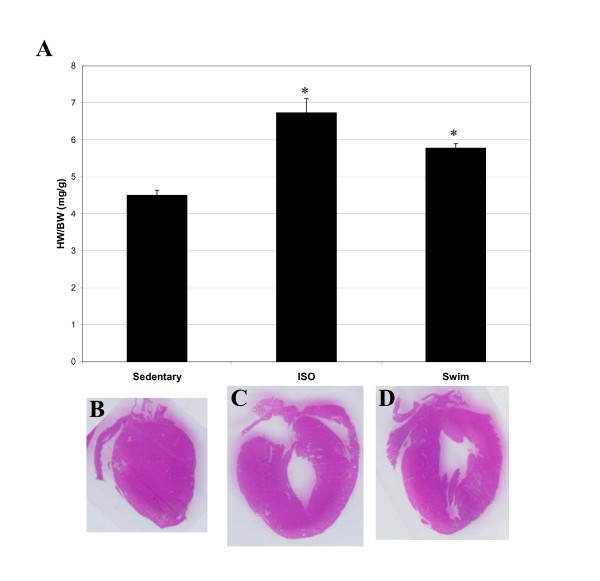
ISO-treatment and exercise induce enlargement of mouse hearts. Top - Heart Weight to Body Weight ratios (HW/BW) for sedentary, ISO-treated or exercised mice. Values are represented as mean ± S.E.M of all mice (8-week old C57BL/6J males). There were 6 mice each in the sedentary group, ISO group, and exercised group. The asterisk denotes statistical significance based on Student's t test for ISO-treated or exercised mice compared to sedentary controls (p value < 0.01). Bottom- Representative histological coronal sections of hearts of sedentary control (A), ISO-treated (B), and exercised (C) C57BL/6J mice. As shown, ISO-treated and exercised mice exhibited enlarged heart masses compared to sedentary mice.